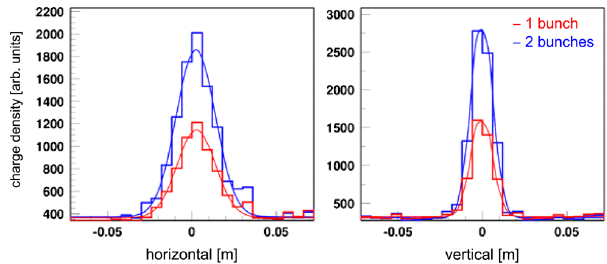
FIG. 10. Transverse beam profiles of extracted beams at the intensity of 2 . 3 × 10 13 ppb, measured by a multiwire profile monitor at the beam dump located in the beam transport to the MLF. Left: horizontal. Right: vertical. are 11 . 31 (cid:3) 0 . 16 mm and 11 . 54 (cid:3) 0 . 10 mm in the cases of acceleration of a single bunch and two bunches, respec- tively. The vertical widths are 6 . 27 (cid:3) 0 . 06 mm and 6 . 33 (cid:3) 0 . 04 mm, respectively. Thus, the beam profiles of the extracted beams are very close in both cases.